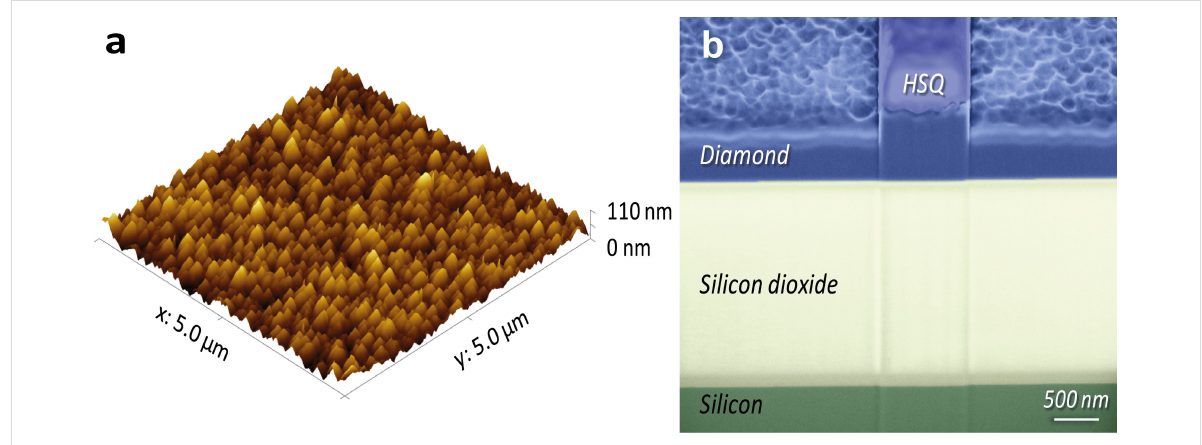
Figure 1: (a) AFM image of the as-grown surface of microcrystalline diamond-on-insulator substrates. Mean surface roughness of 15 nm rms is deter- mined. (b) Cross-sectional SEM image of a nanophotonic waveguide cut by focussed-ion-beam milling. The diamond, e-beam resist, and buried oxide layers are marked in a false-colour